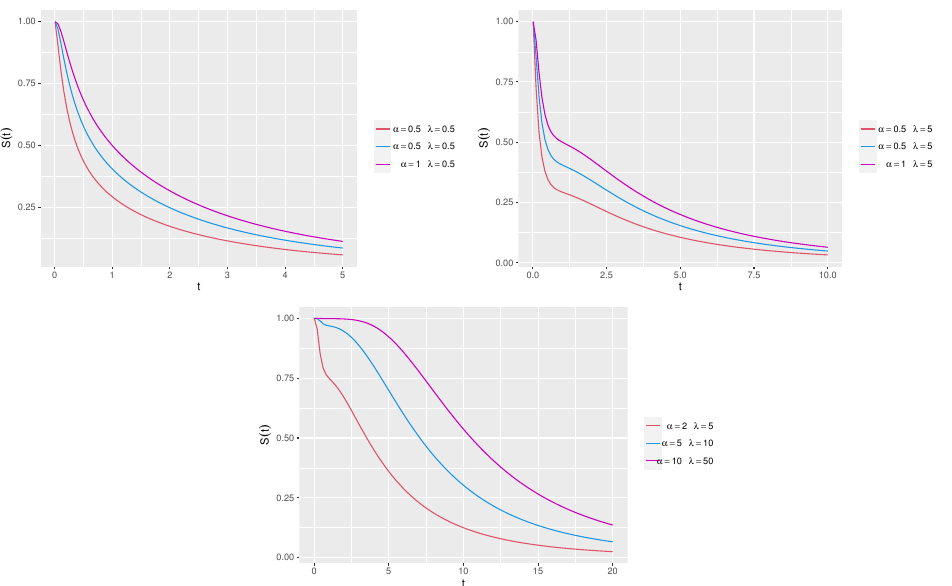
Figure 4. Survival function of the EEBLN distribution for some selected values of α